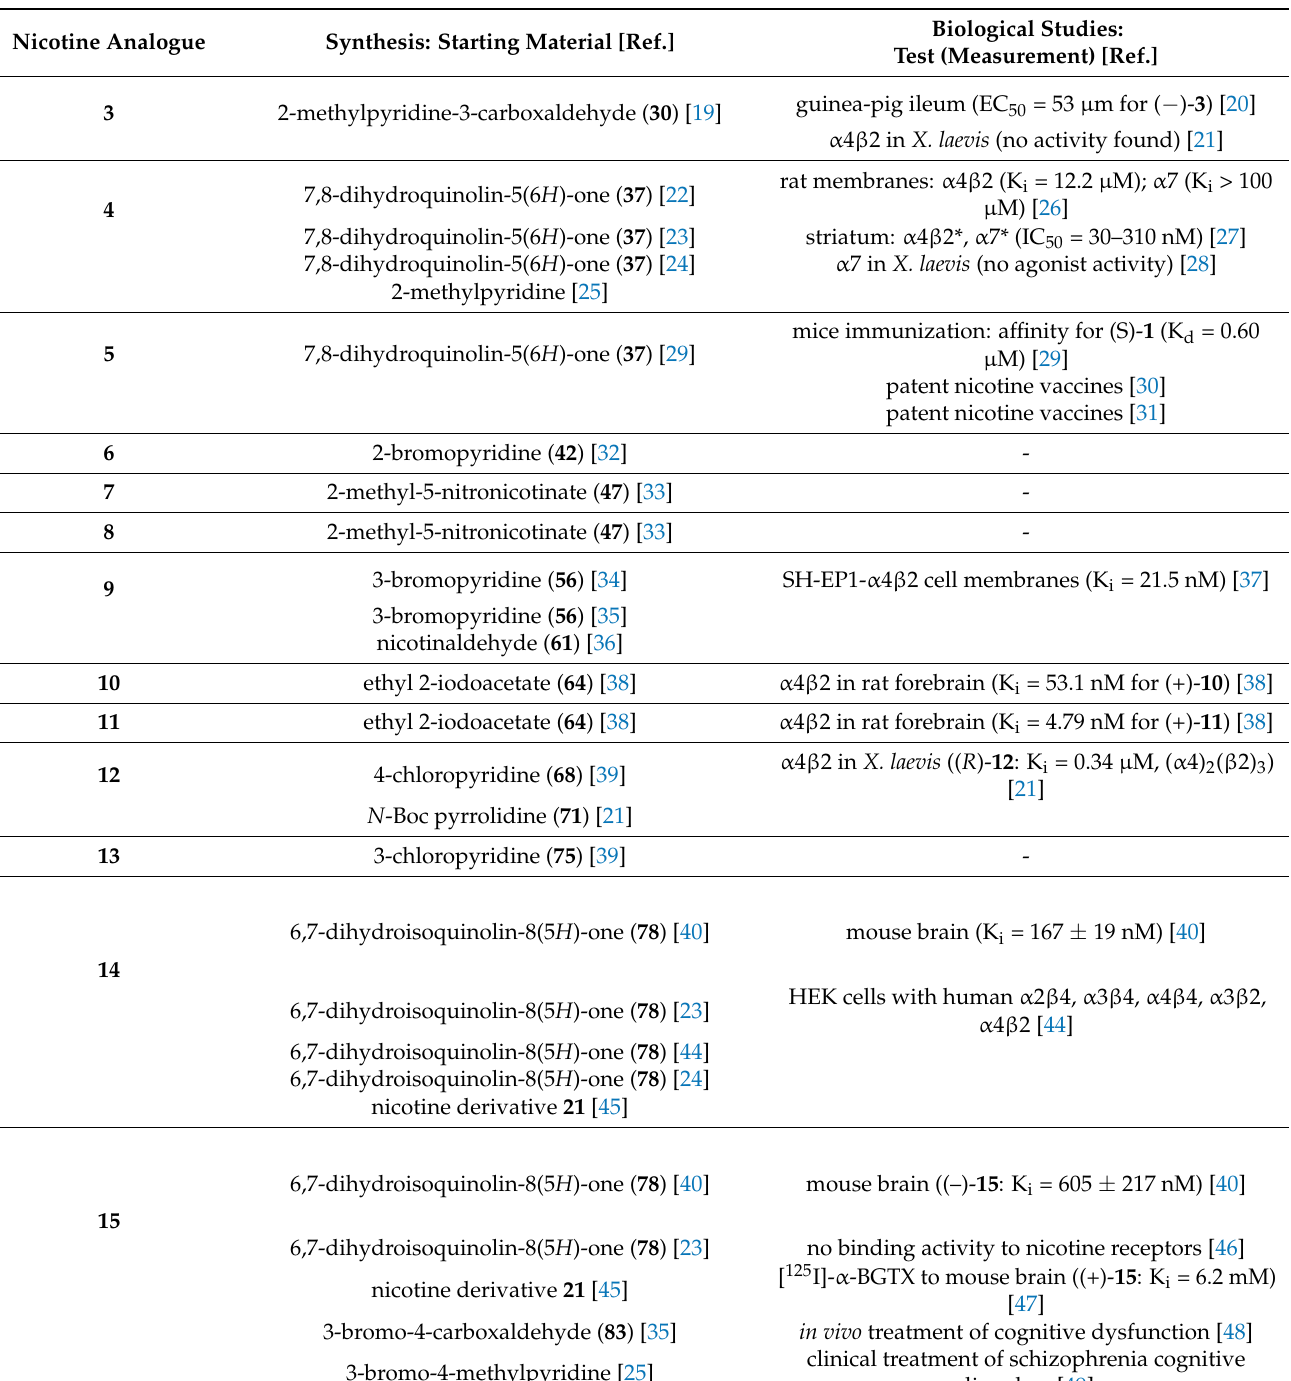
Table 1. Summary of the literature concerning the synthesis and the biological characterization of conformationally constrained nicotine analogues considered in the present mini-review. Nicotine Analogue Synthesis: Starting Material [Ref.]